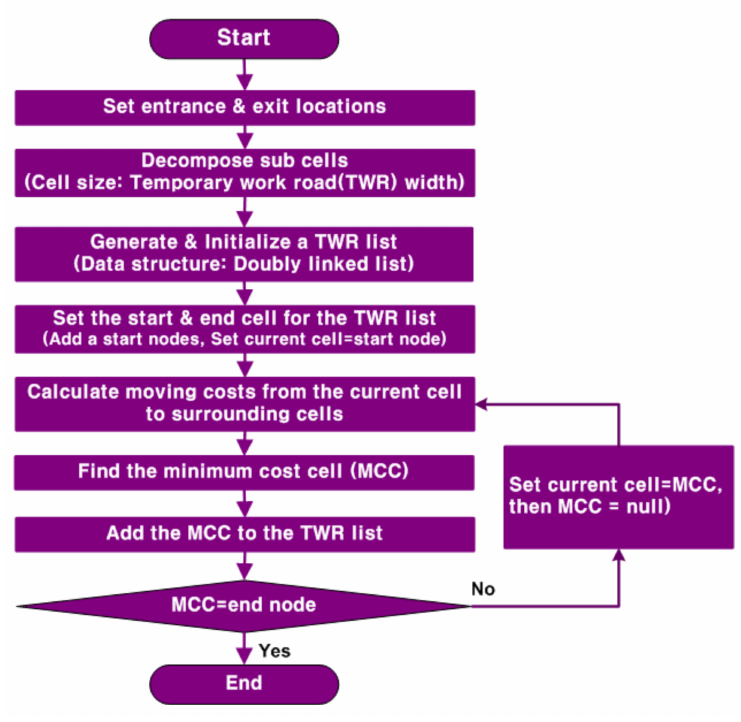
Figure 4. Process of generating a temporary work road